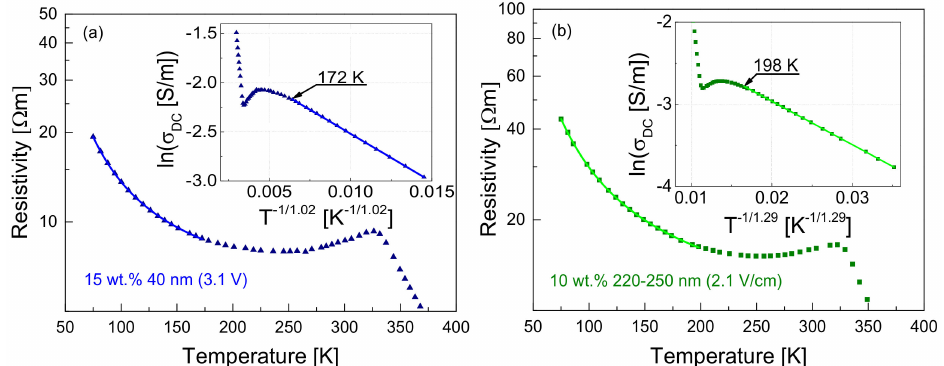
Figure 4. Changes of sample resistivity as a function of temperature for composites filled with 15 wt.% of OLC particles of size 40 nm ( a ), and with 10 wt.% of OLC particles of size 220–250 nm ( b ). Dots represent experimental results and solid lines represent fits for tunneling (Equation (3)). Insets represent fitting for variable-range hopping (Equation (4)). The indicated electrical field values are the values applied to the sample at room temperature (290 K).